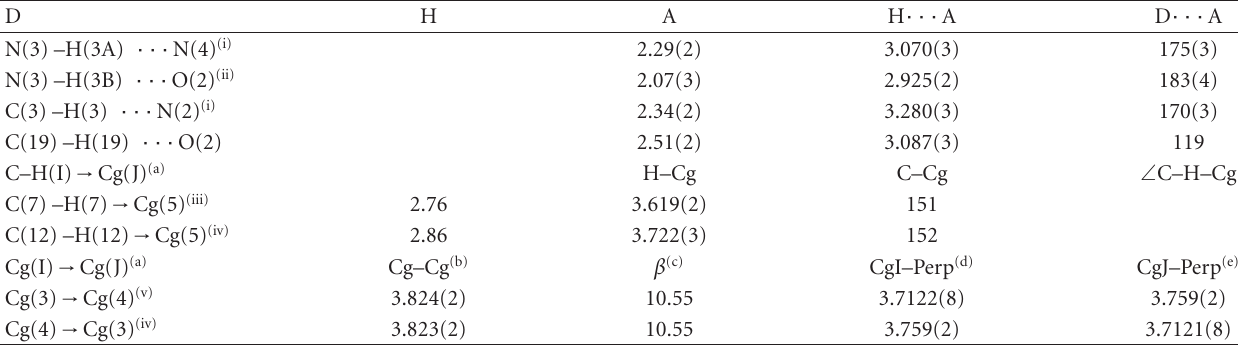
Table 3: Geometric parameters for hydrogen bonds and for C–H— π and π ··· π interactions in 2